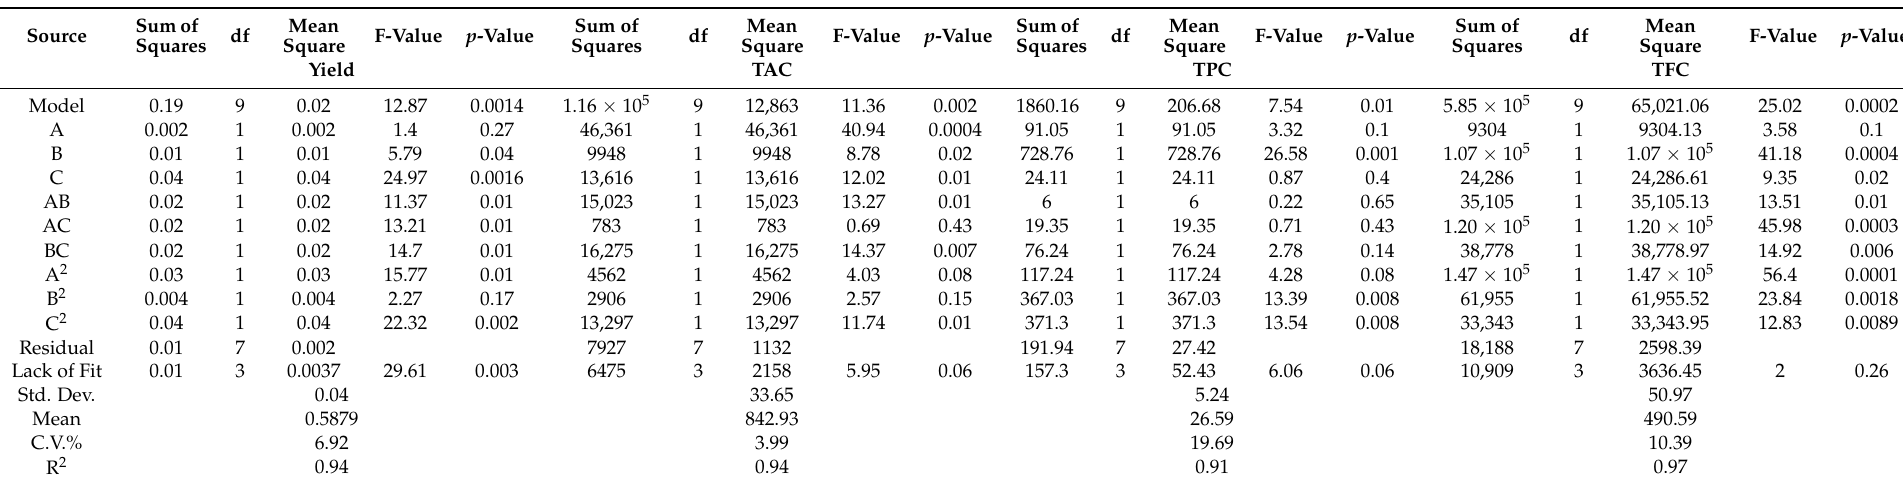
Table 2. ANOVA table for the responses of yield, TAC, TPC, and